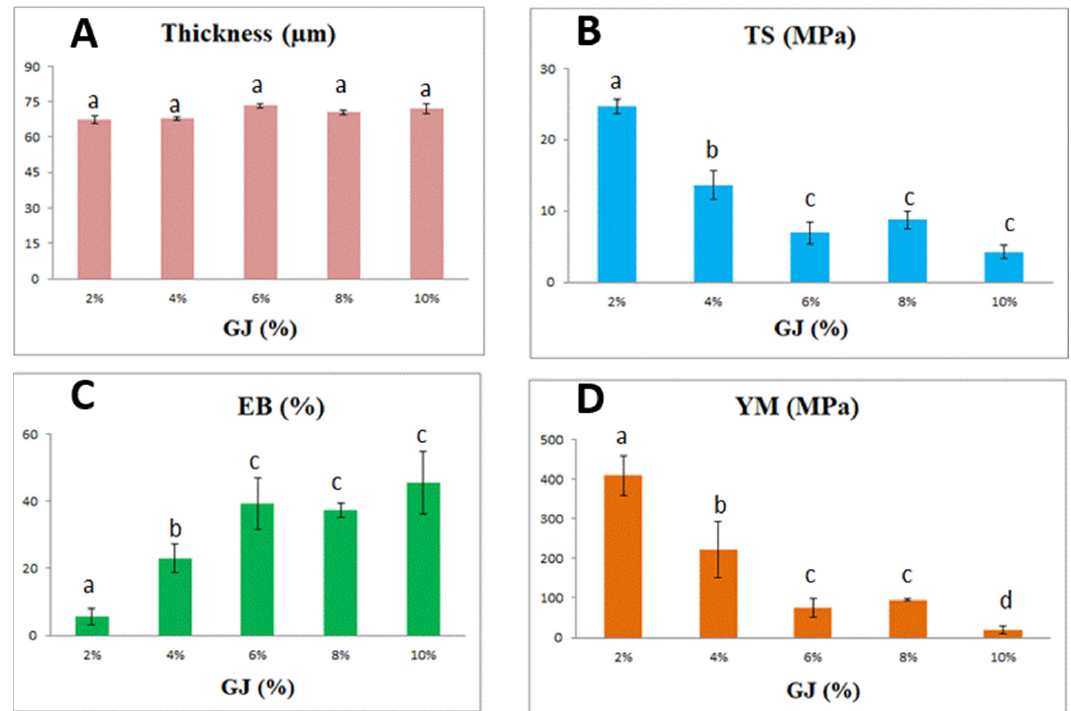
Figure 2. Demonstrates the effect of different concentrations of grape juice (GJ) on the film thickness ( A ) and mechanical properties (TS—tensile strength ( B ); EB—elongation at break ( C ); YM—Young’s modulus ( D ) of NSPC edible films obtained at pH 12.0. Different statistical symbols ( a – d ) indicate significant difference between treatments ( p < 0.05).